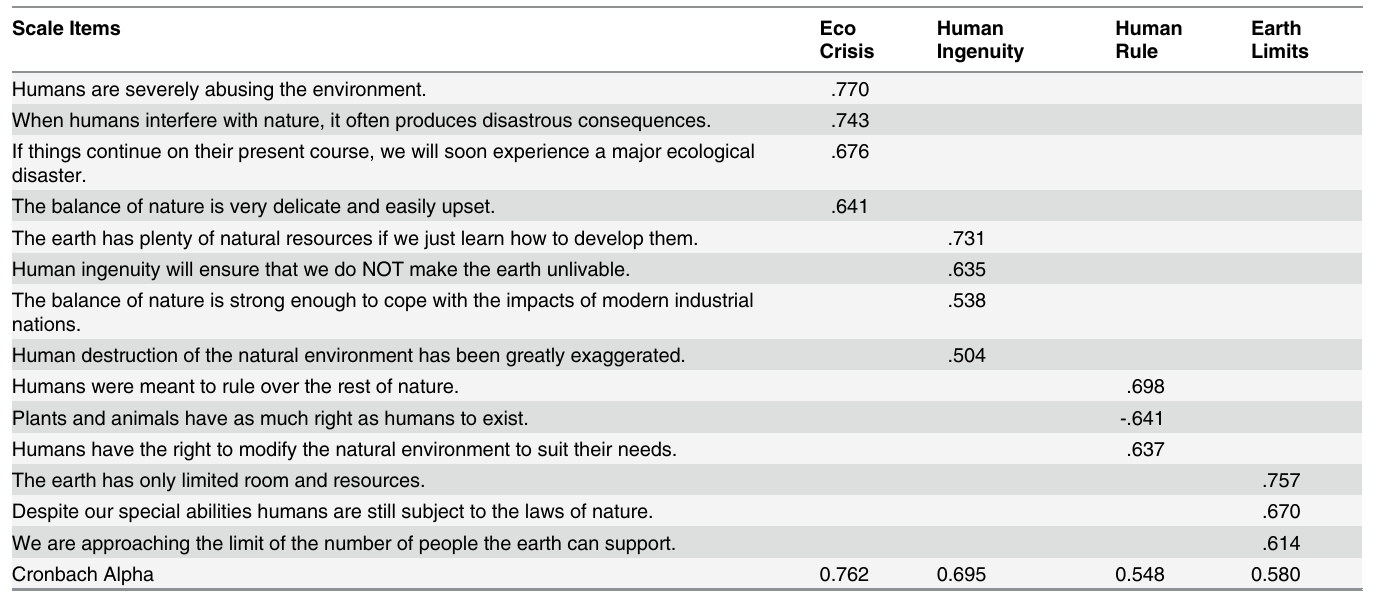
Table 4. Rotated component matrix from the factor analysis, plus Cronbach Alpha (reliability) for each